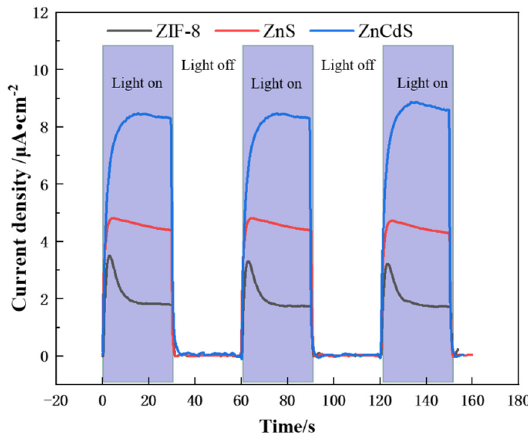
Figure 9. Transient photocurrent responses of catalysts.